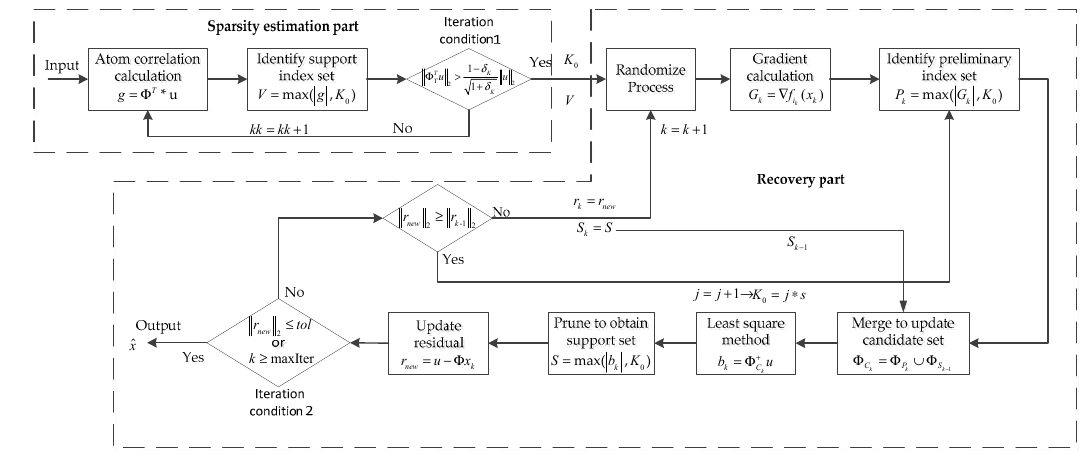
Figure 1. Block diagram of the proposed algorithm.